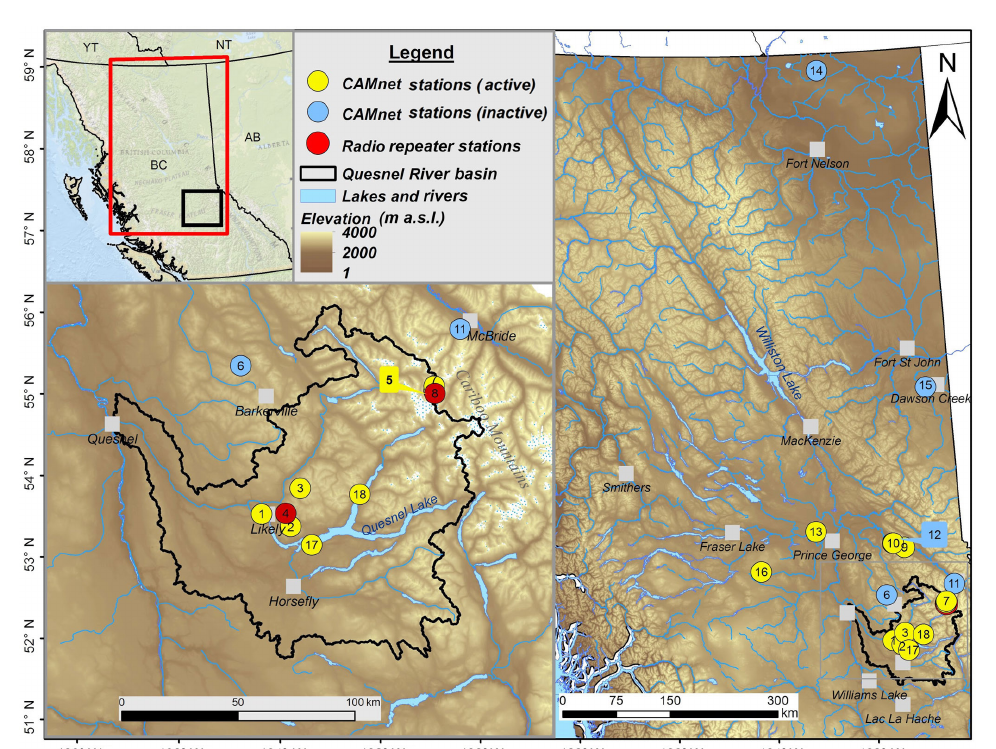
Three additional weather stations mounted on 3 m tripods were also deployed during summer 2006 near Likely, BC, in an attempt to capture the effects of elevation gradients on atmospheric conditions in the Cariboo Mountains.